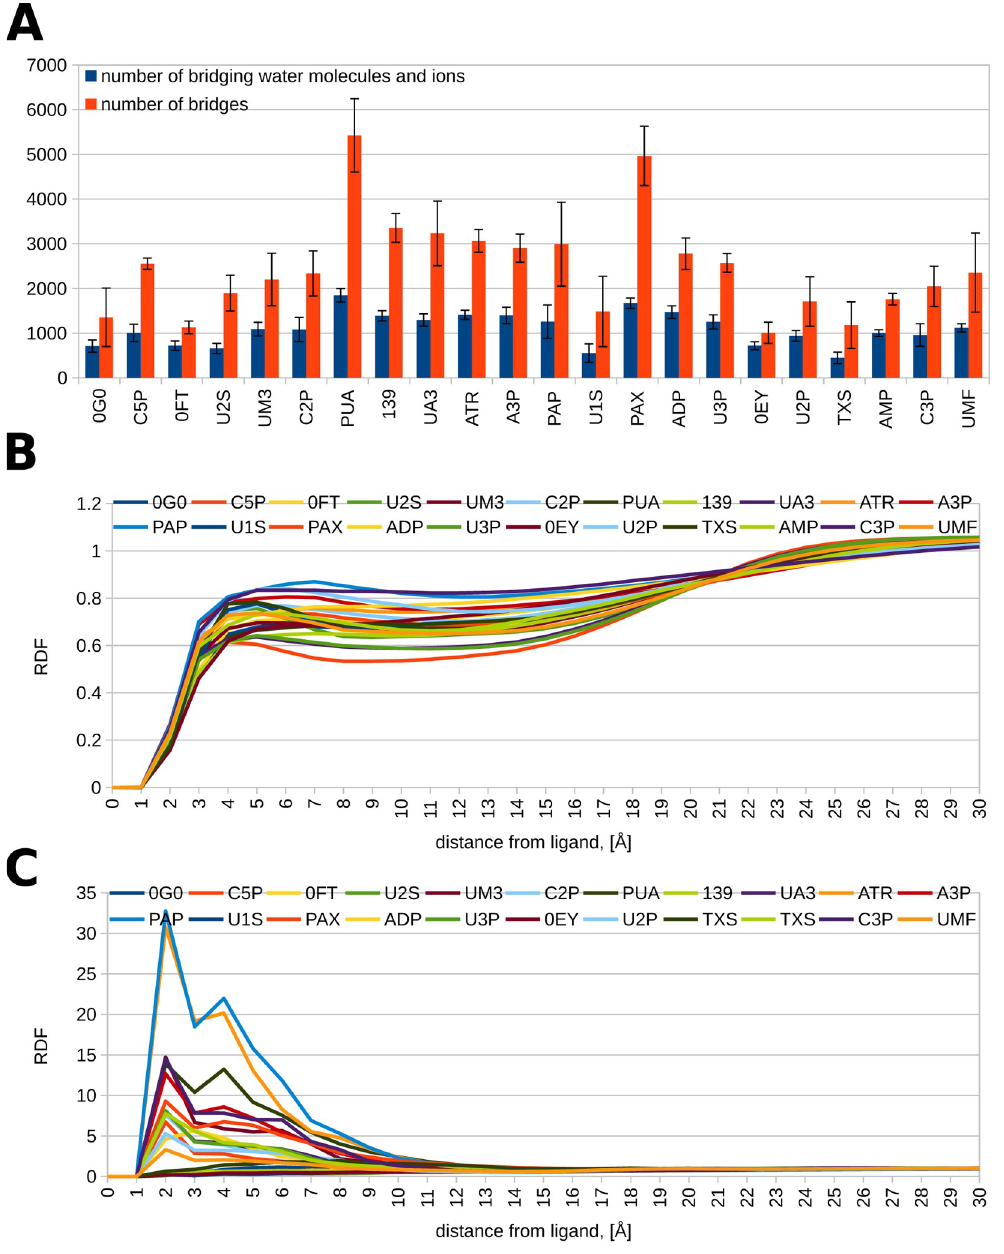
Fig 5. Average numbers of bridging water molecules and ions, and bridging water–ligand and bridging Na + —ligand RDFs. (A) For every compound, we give the average number of bridging molecules (blue columns) and bridges (red columns) for the four production runs; error bars represent standard deviations. (B) Bridging water–ligand radial distribution functions computed from the four 100 ns production dynamics simulations for every compound. (C) Bridging Na + –ligand radial distribution functions computed from the four 100 ns production dynamics simulations for every